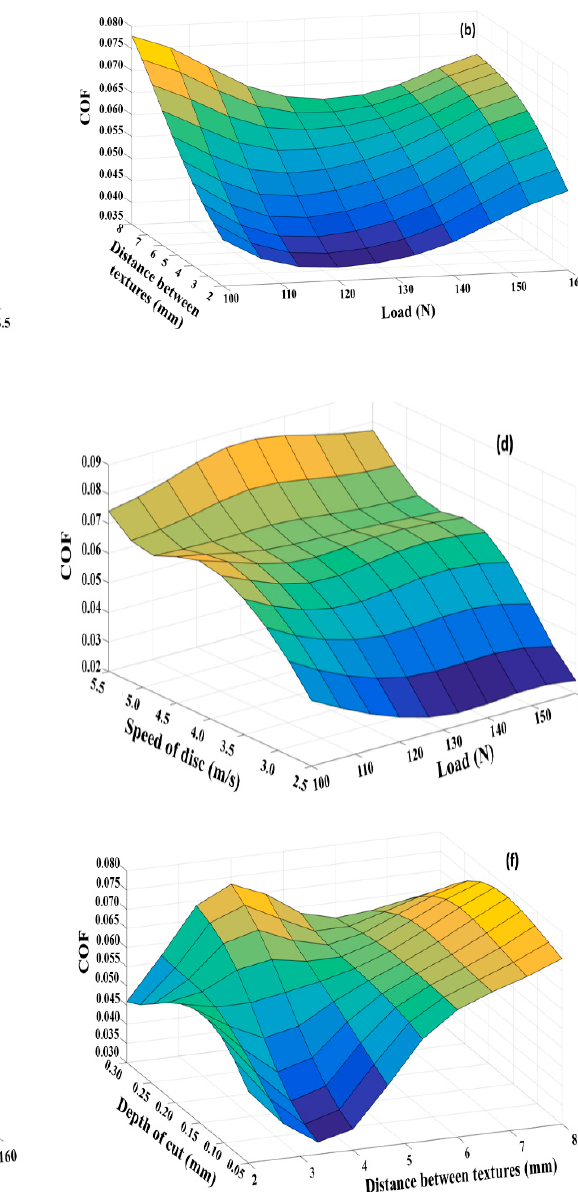
10 of 17 Figure 7. ( a ) Scatter plot for the circular grooves; ( b ) sensitivity analysis of the chosen ANN model for the circular grooves; ( c ) scatter plot for the perpendicular grooves; ( d ) sensitivity analysis of the chosen ANN model for the perpendicular grooves. The surface plots (Figure 7) of the circular grooves with the applied ANN show that with the increase in the distance between the textures, depth of the cut and the speed of the disc, there was an increase in the COF. Additionally, the COF increased in the case of the circular grooves with the increase in the load. As seen from Figure 8a, the coefficient of friction initially decreased with the increase in the speed, but as the speed increased, the COF also increased. Similarly, as the distance between the grooves increased, the COF also increased (Figure 8b). Additionally, the increase in the depth of the cut (Figure 8c)